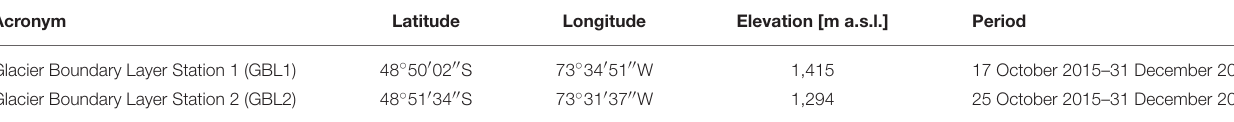
TABLE 1 | Details of the two UDGs at the GBL